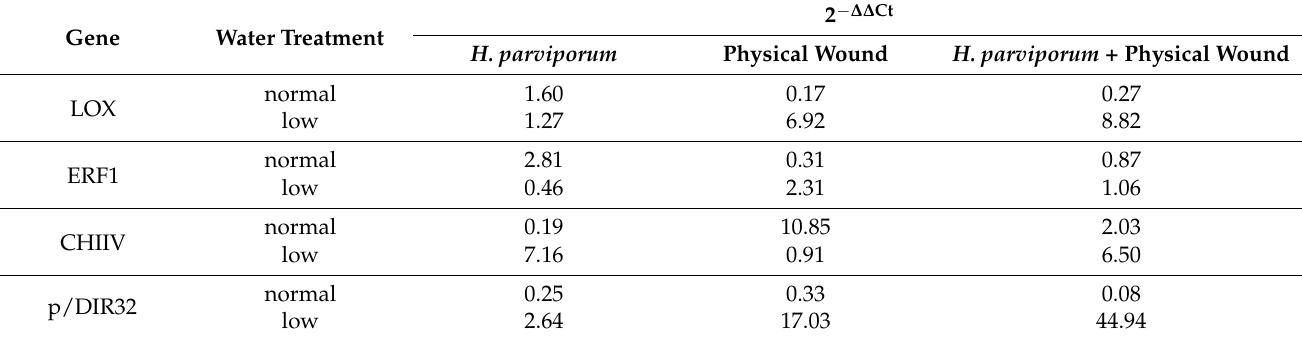
Table 4. Comparative Quantification Determining Mean Fold Change (2 − ∆∆ Ct ) in Gene Expression Mediated by H. parviporum Infection only, Physical Wounding only, and the Combination of both H. parviporum Infection and Physical Wounding Caused by Inoculation.